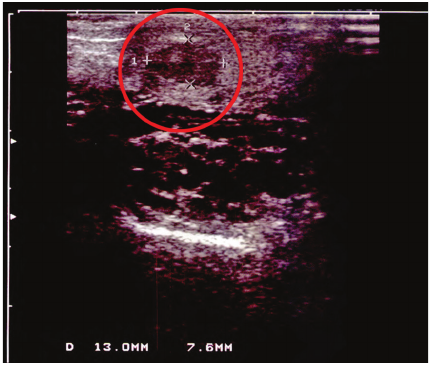
Figure 1: Tumor (red circle) and high-grade varicocele in sonogra- phy.